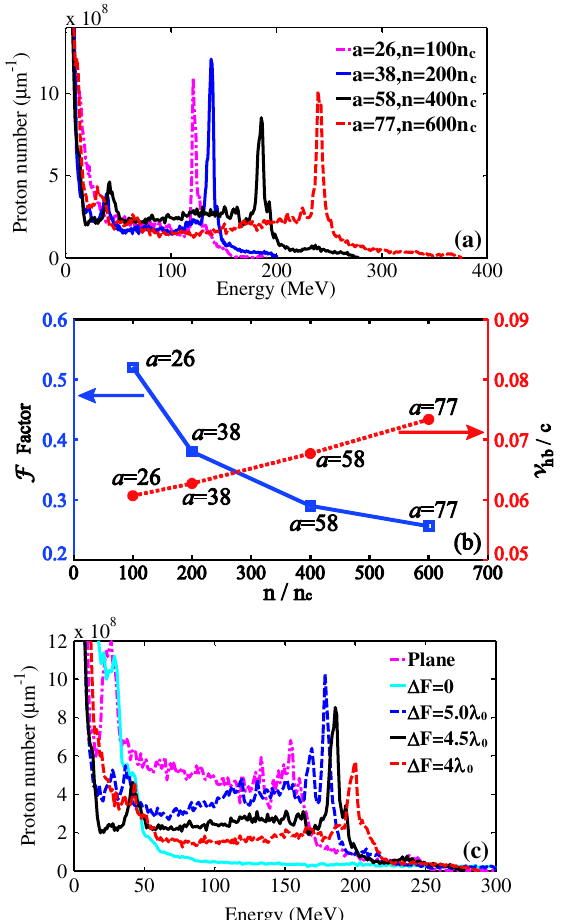
FIG. 5. (a) The energy spectra of protons ( 29 (cid:1) 0 < y < 31 (cid:1) 0 ) from different simulations under different target density n and normalized peak laser amplitude a at t ¼ 64T 0 . (b) The variation of the F value and the hole-boring velocity v hb with the simulation parameters (laser amplitude a and the target density n ) as those in (a). (c) Comparison of the energy spectra obtained with a plane target and with the DPT target design with different (cid:3) F t ¼ 64T (cid:1)F ¼ F 1 2 at 0 , where the initial normalized peak laser amplitude is fixed at a ¼ 58 and the target density at n ¼ 400